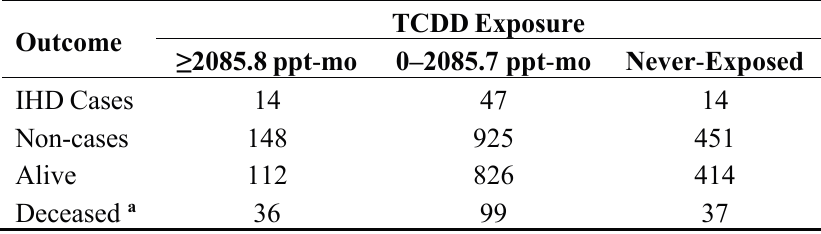
Table 1. Cell counts used to estimate the crude odds ratio and 95% confidence limits for the association between occupational TCDD exposure and ischemic heart disease using data reported by McBride et al.